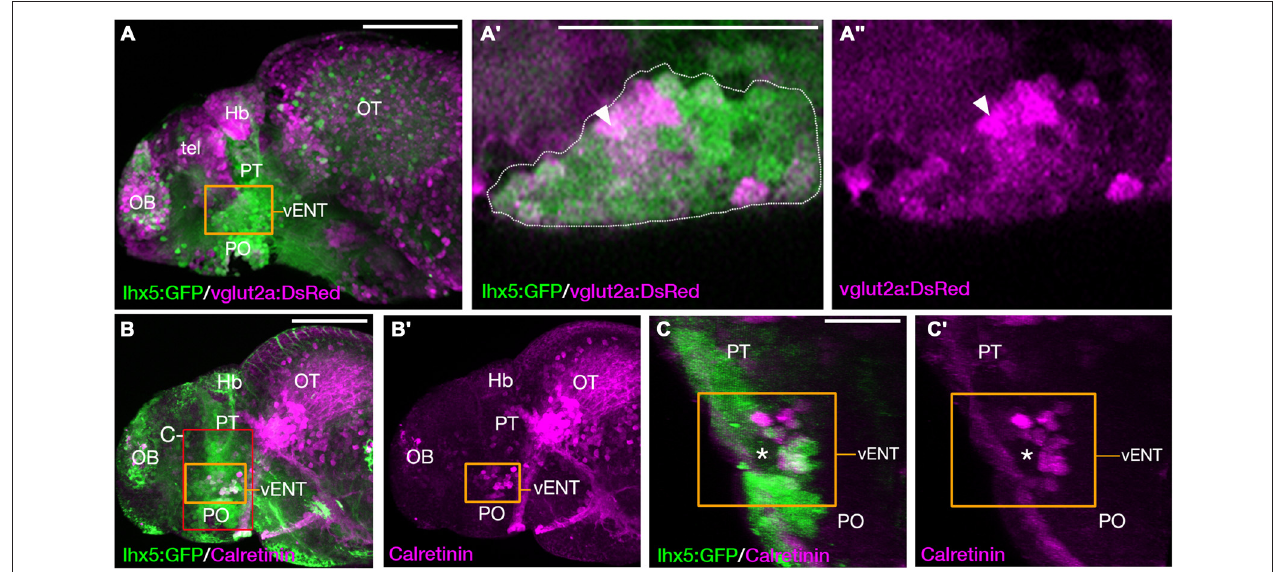
FIGURE 8 | The larval vENT contains glutamatergic and calretinin-positive populations of cells. (A,A (cid:48)(cid:48) ) Confocal images of Tg(lhx5:GFP) b1205 / Tg(slc17a6b:DsRed) nns9Tg 4 dpf double transgenic larvae labeled with anti-GFP and anti-DsRed antibodies (green and magenta respectively). GFP expression shows the previously identified vENT (orange box in A , enlarged in A (cid:48) ,A (cid:48)(cid:48) ). Enlarged views of single confocal sections (A (cid:48) ,A (cid:48)(cid:48) ) show co-expression of GFP and DsRed in a subpopulation of cells (arrowheads) of the GFP+ vENT (dotted line in A (cid:48) marks). (B–C (cid:48) ) Tg(lhx5:GFP) b 1205 4dpf larvae labeled with anti-GFP (green) and anti-calretinin (magenta). (B,B (cid:48) ) lateral view shows a subset of GFP+ vENT neurons (bound by orange box) express calretinin. (C,C (cid:48) ) 3D transverse sections of same larvae (B) cropped to area delineated by red box in (B) . Calretinin+ and GFP+ neurons within the vENT, which surrounds the lateral forebrain bundle (lfb; asterisk). Scale bars: (A,B) 100 µ m; (A (cid:48) ,C) 50 µ m.